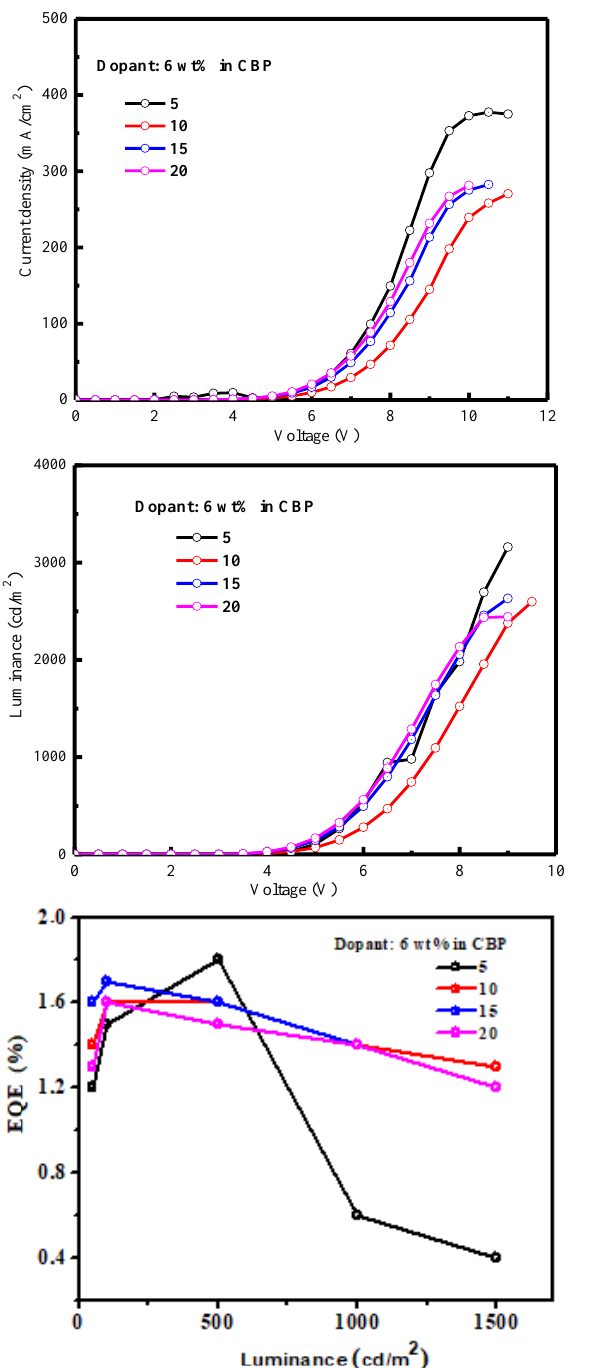
Figure 4. OLED characteristics of the multilayer devices: ITO/PEDT/emitter 6 in CBP/TPBI/LiF/Al.